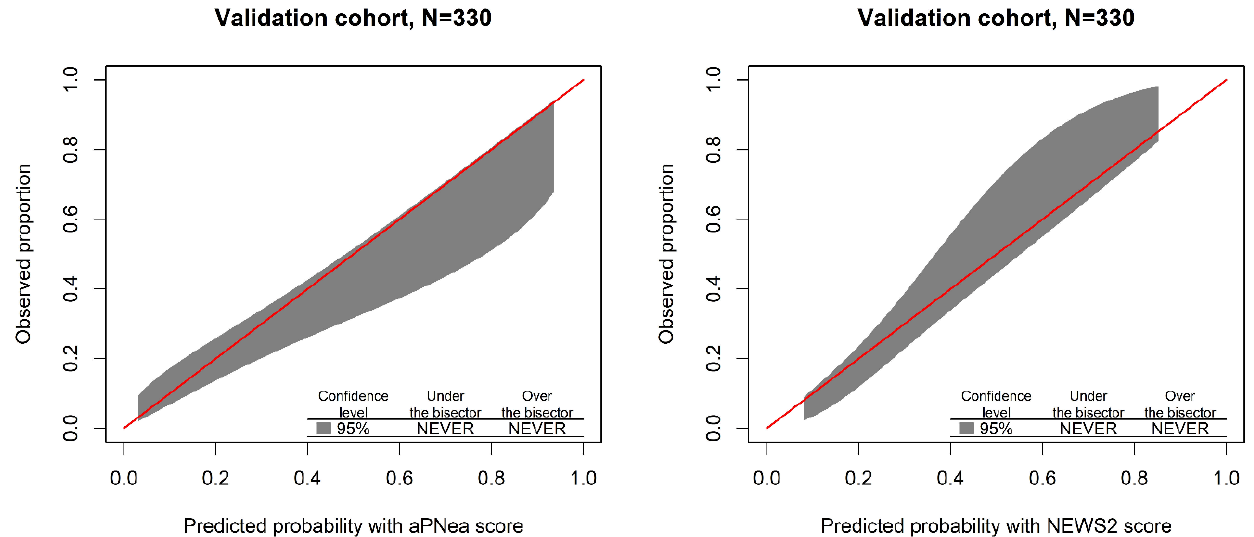
Figure 2. Calibration graph presenting the polynomial function and 95% confidence band of the relationship between the predicted outcome probability and the observed proportions in the validation cohort for each score model. The red bisector represents the equality line, where the predicted probability and observed proportion correspond. The range of probabilities where the model overestimates (under the bisector) or underestimates (over the bisector) the outcome is evidenced in the plot. If the model does not overestimate or underestimate the outcome outside the 95% confidence band, the word NEVER is used.